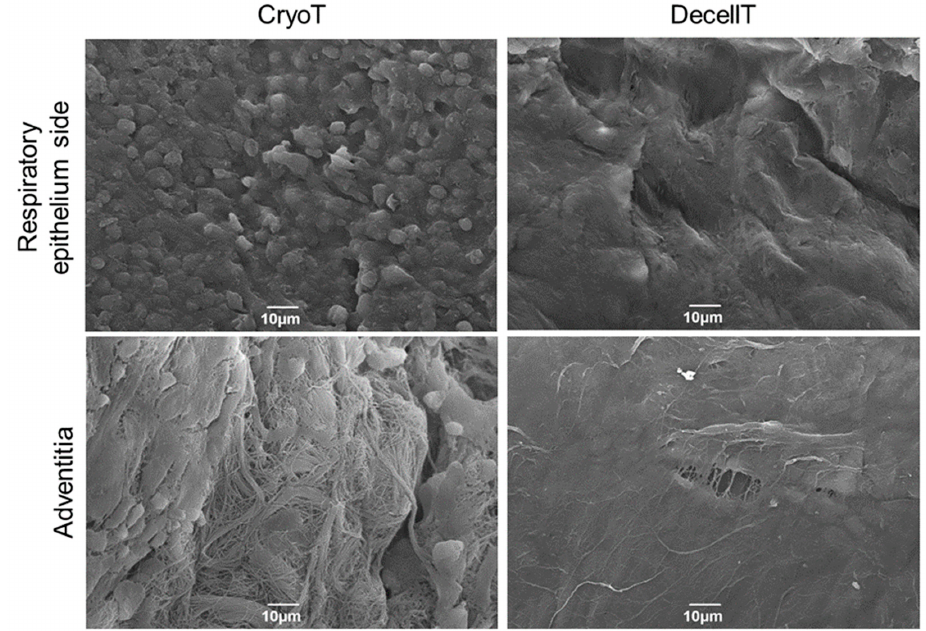
Figure 17. Ultrastructural characterization of retrieved cryopreserved (CryoT) and decellularized (DecellT) samples after heterotopic implant in Balb/C mice (end-point: 14 days). The respiratory epithelium side and the adventitia were both considered. Scale bars: 10µm.